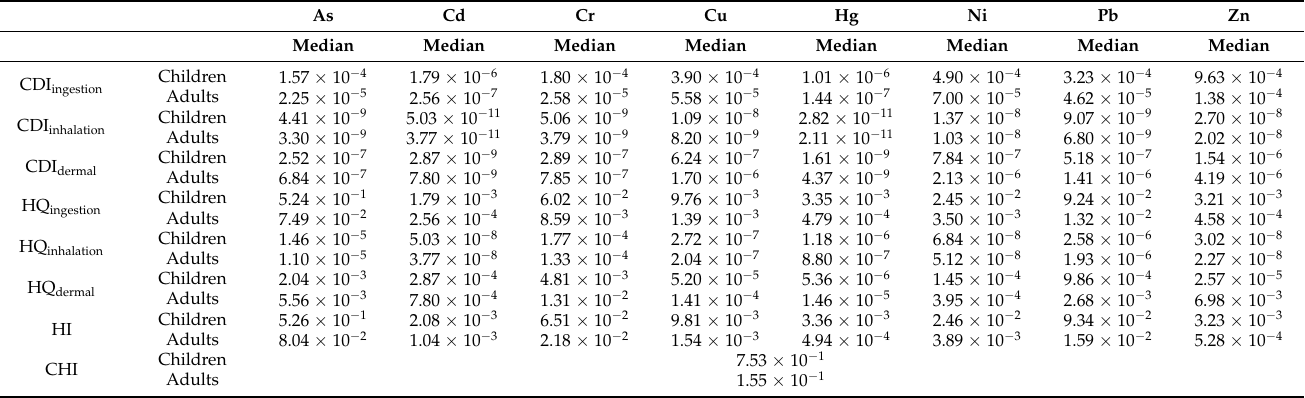
Table 6. Median values of non-carcinogenic risk indictors to humans from soil